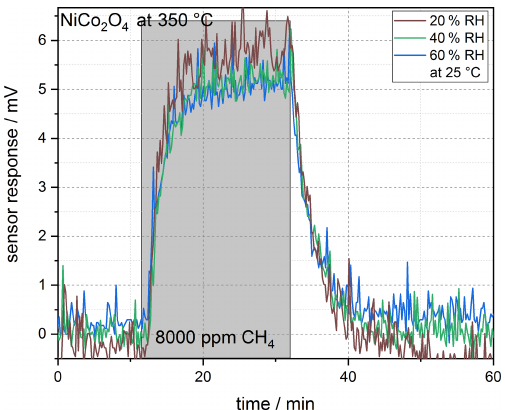
Figure 6. The influence of different relative humidity levels on the gas sensor response to 8000ppm CH 4 in synthetic air at an ambient temperature of 25 ◦ C. The variation of the measurement results is quite low, so the change in humidity has only a minor influence on the sensor